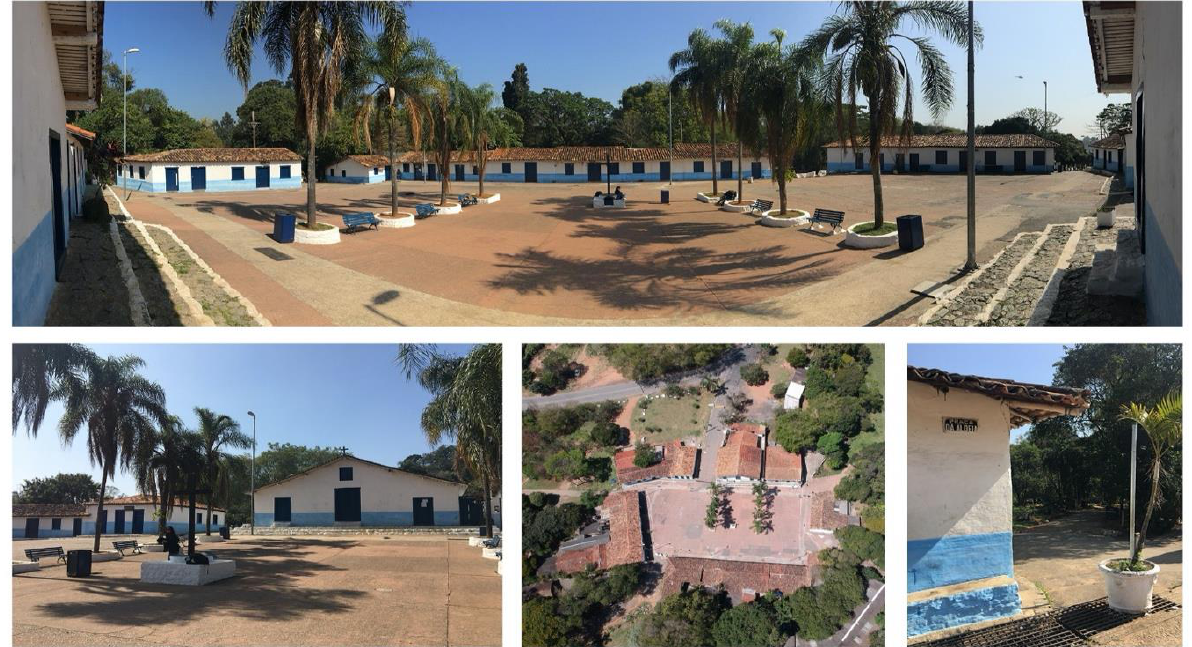
Figure 4. Overview and views of the village of